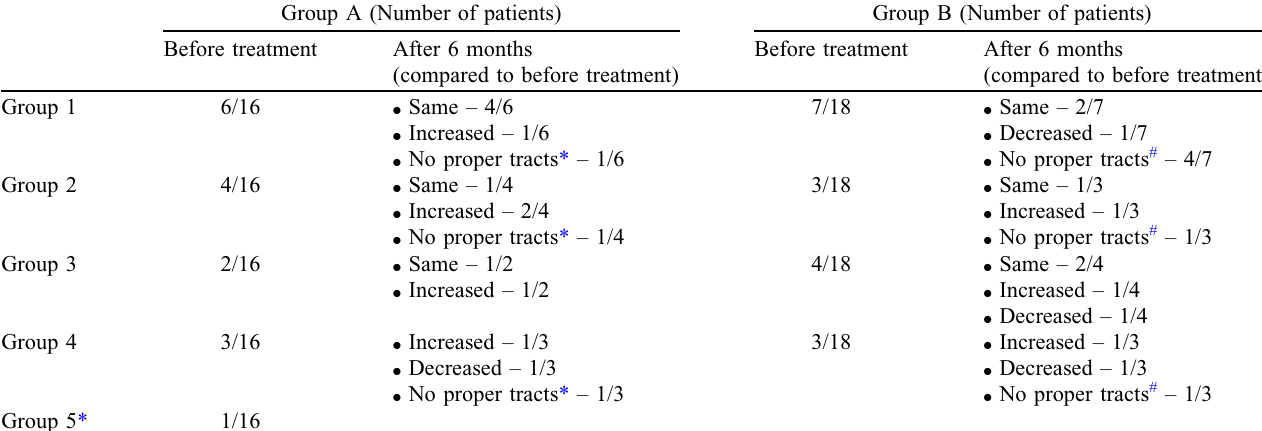
Table 3. Results of tractography among groups A and B.